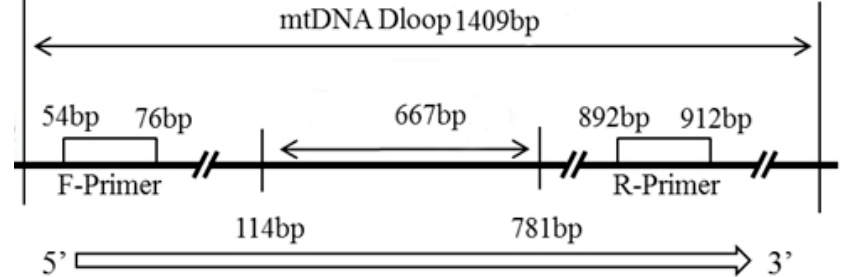
Figure 2. The site of primers according to the Beijing duck sequence (GenBank accession number NC_009684L16770).